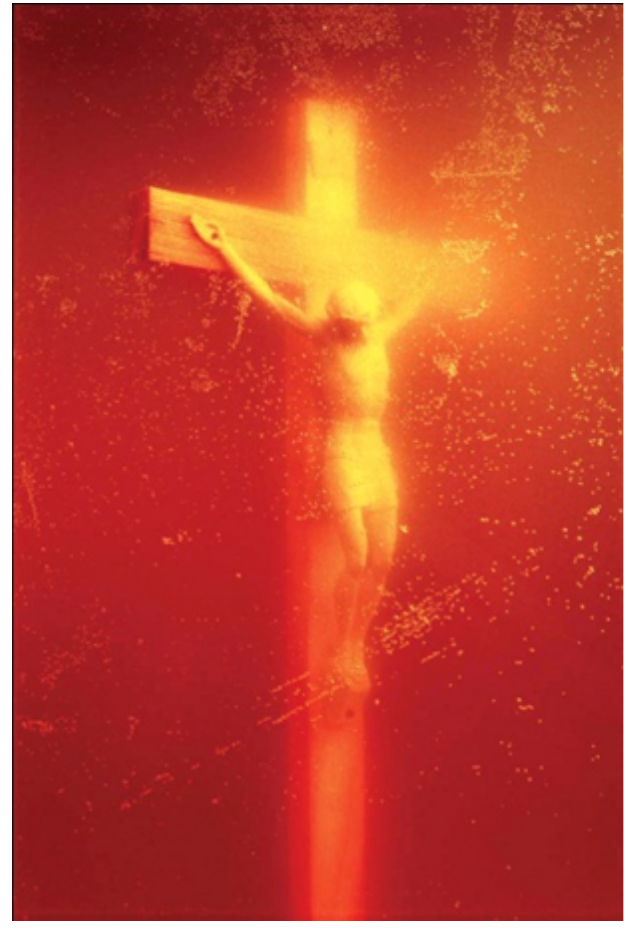
Andres Serano, Piss Christ , 1987. Cibachrome print, 45 1/4 x 32 3/4 in. (114.9 x 83.2 cm.) Courtesy of Edward Tyler Nahem Fine Art, New York